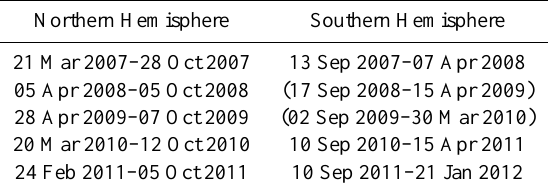
analysis. The periods left out for Figs. 9 and 10 are in parentheses.